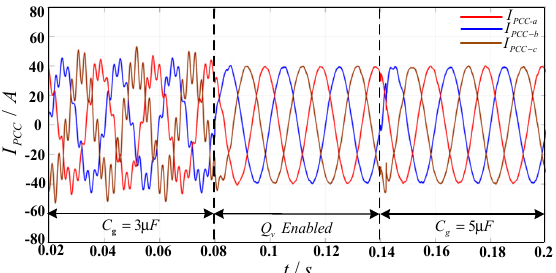
Figure 17. Simulation result of current waveform at PCC when different C g is applied.